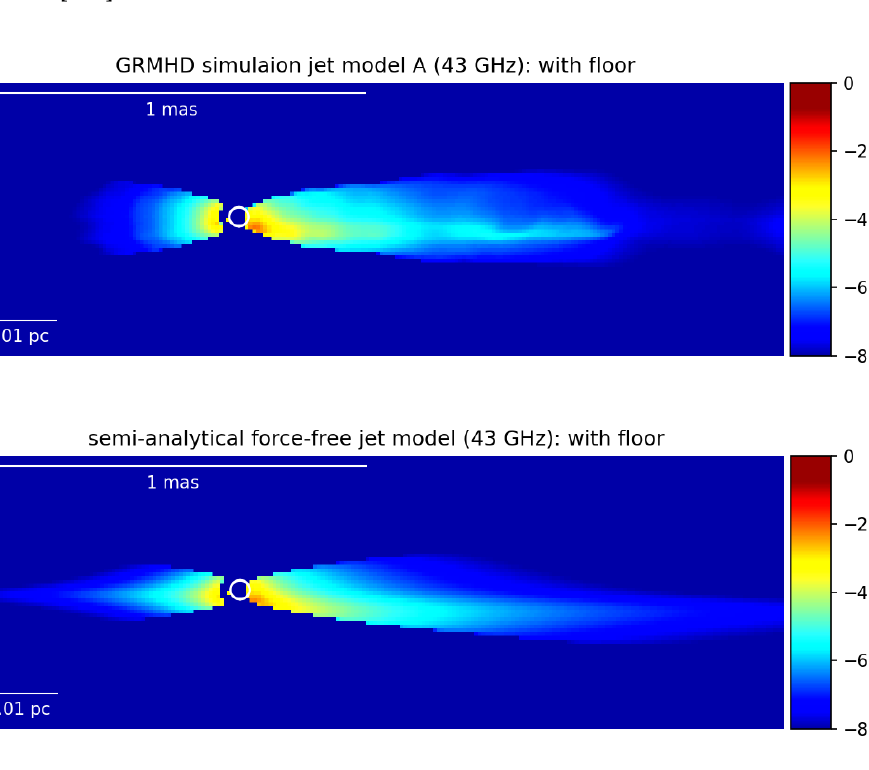
Figure 5. Model synchrotron images at 43 GHz for GRMHD jet model A (with floor) and force-free jet model (with floor). Emissions below floor height z = 10 R g of the black hole are